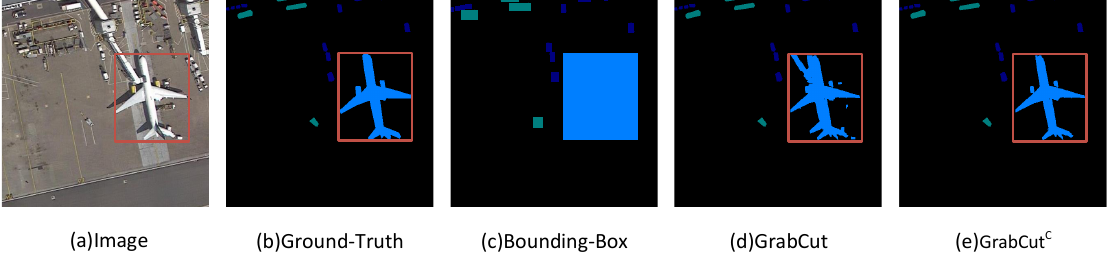
Figure 2. Segmentation proposals obtained from bounding box. ( a ) A training image. ( b ) Ground truth. ( c ) Rectangle proposals. ( d ) GrabCut [29] proposals. ( e ) We propose GrabCut C proposals, which perform better than traditional